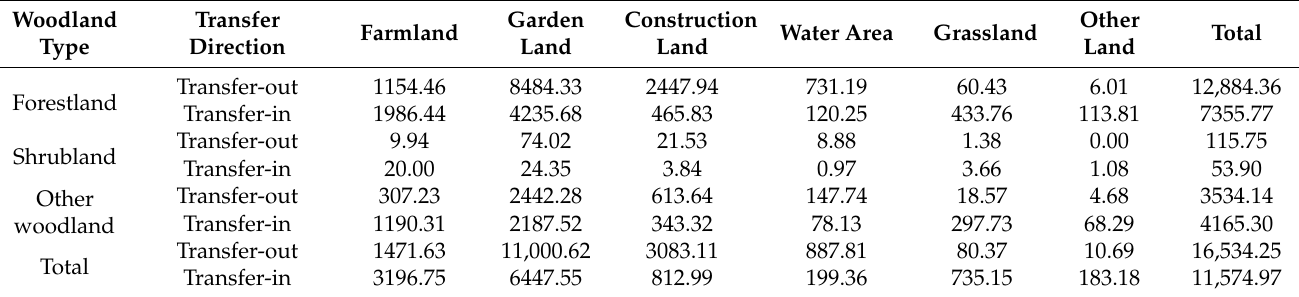
Table 6. Transfer matrix of woodlands in Anyuan County, 2009–2019 (Unit: ha).